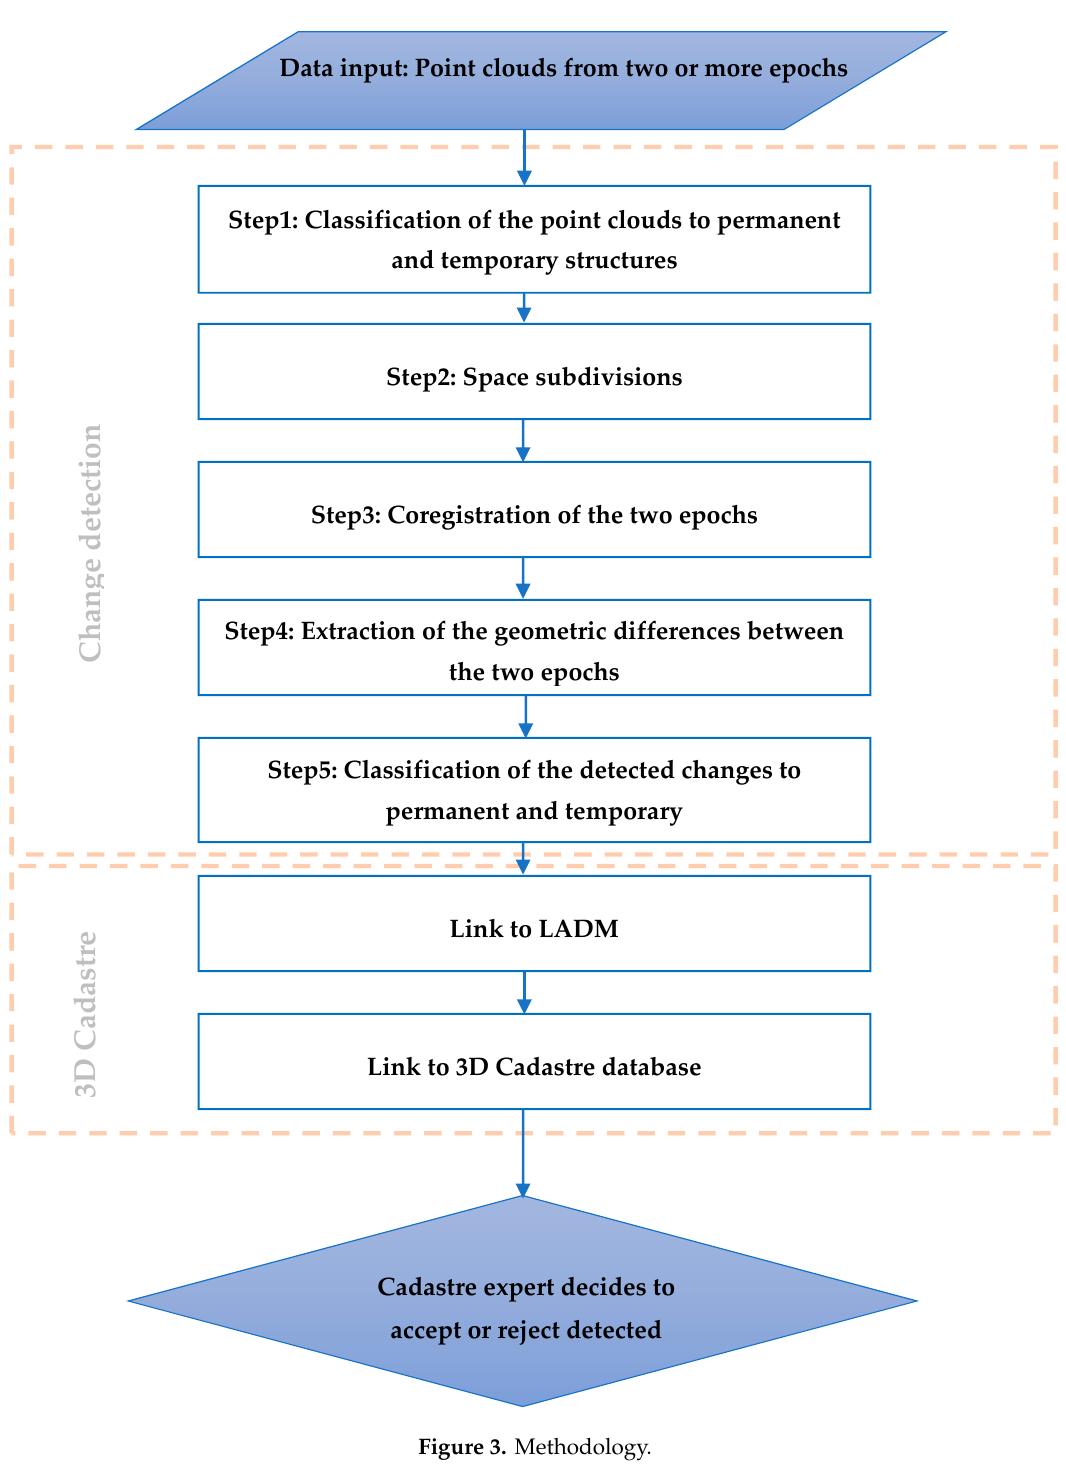
Figure 3. Methodology. Figure 3.